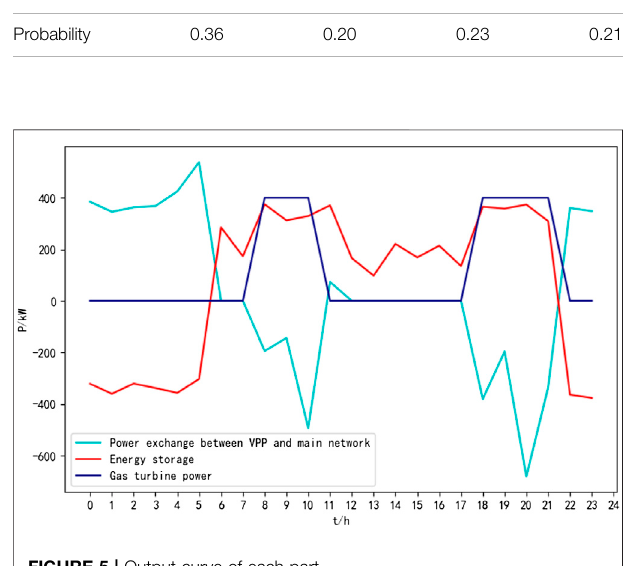
FIGURE 5 | Output curve of each